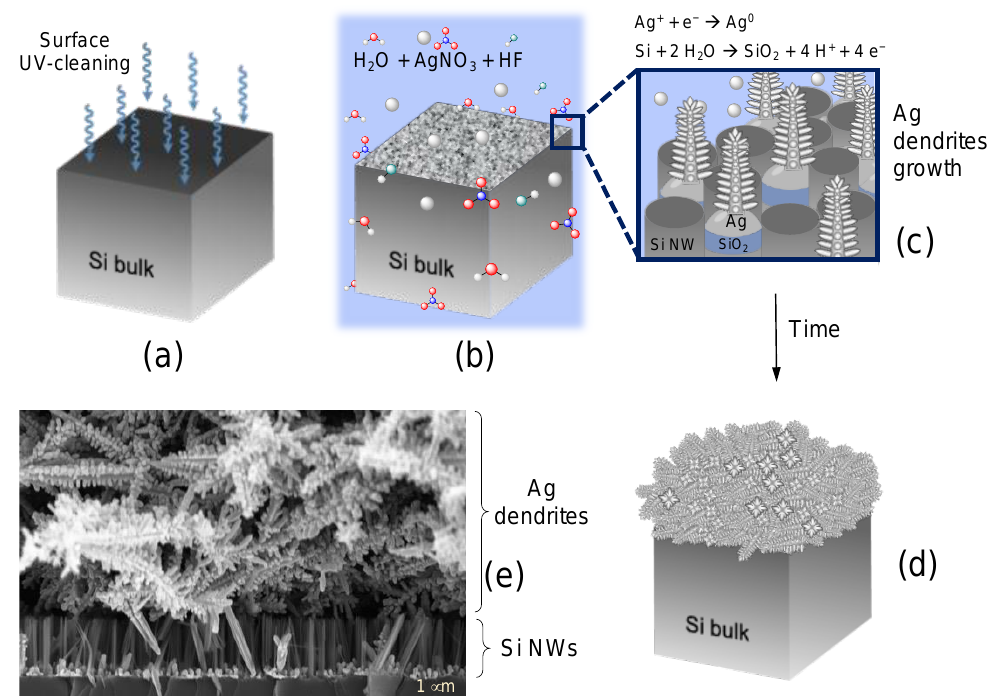
Figure 1. Scheme for the realization of silver dendrite fractal system by metal-assisted chemical etching. ( a ) The Si wafer is first treated for the removal of organic contamination by UV–ozone cleaning, for the removal of native oxide,, and then ( b ) etched in an AgNO 3 /HF solution. During the etching, ( c ) the formation of Ag dendrites occurs as a byproduct of the reaction, ( d ) and the final effect is the formation of a dense film of silver fractal dendrites. ( e ) Cross-section scanning electron microscopy of the fractal silver dendrites lying on top of Si nanowire structure.